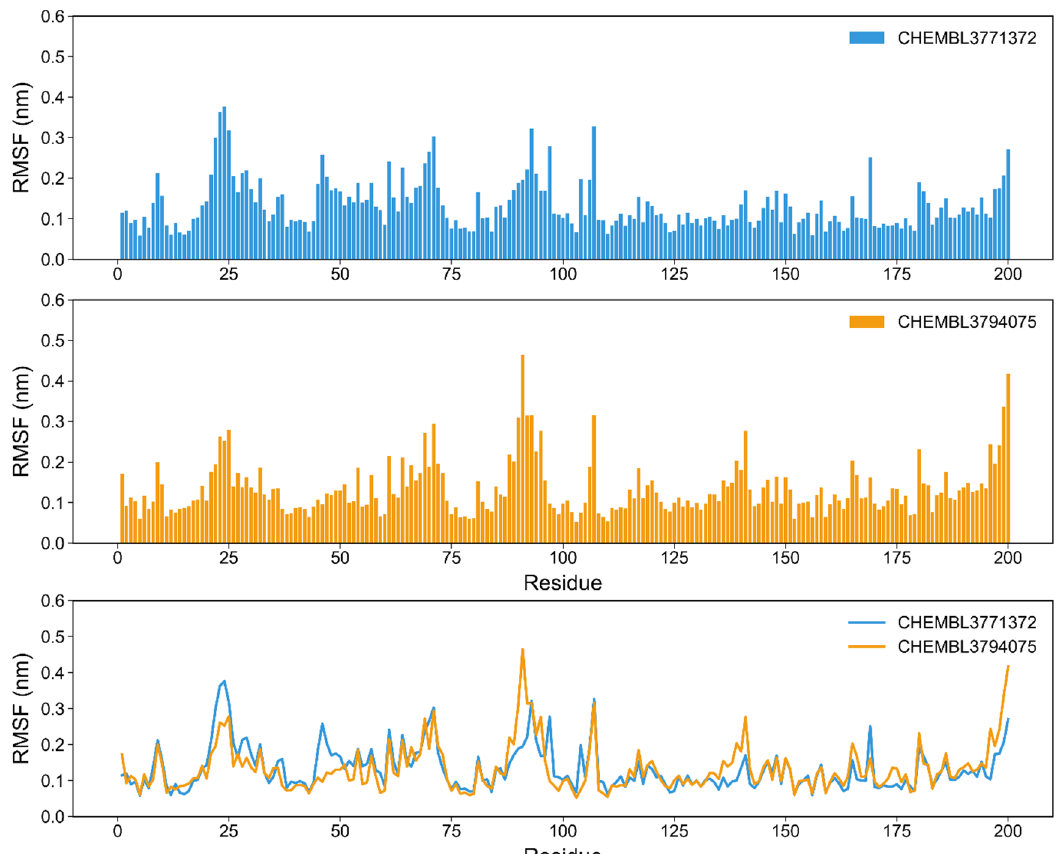
Figure 15. RMSF plots of the P20S’ β 5 subunit for the simulations with both selected molecules, CHEMBL3771372 and CHEMBL3794075. Residue IDs in the x -axis refer directly to the sequence numbers associated with 5LF3 (chain beta type-5). RMSF values for β 5 are shown in Supporting Figure S7.